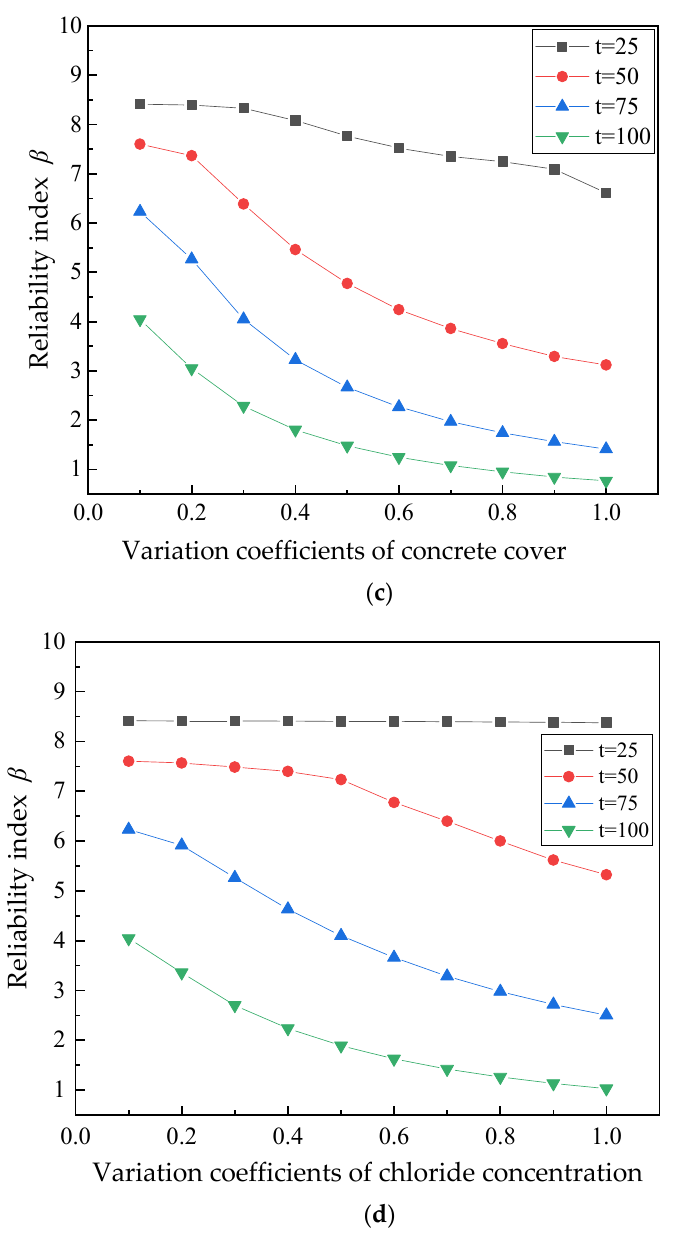
Figure 9. Influence of the variation coefficient of a parameter on the reliability index. ( a ) Relationship curve between cohesion and time-varying reliability. ( b ) Relationship curve between internal friction angle and time-varying reliability. ( c ) Relationship curve between the concrete cover and time-varying reliability. ( d ) Relationship curve between chloride concentration and time-varying reliability